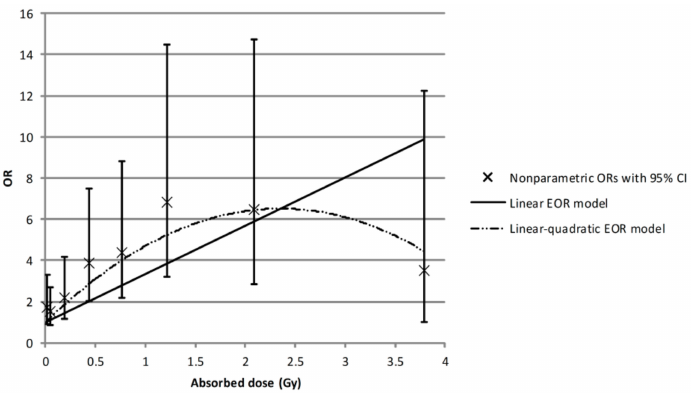
Figure 2. Association between 131 I thyroid dose and thyroid cancer, risk adjusted for self-reported personal history of benign nodules in the study subjects with 131 I thyroid absorbed doses < 5 Gy. Note: OR = odds ratio; EOR = excess odds